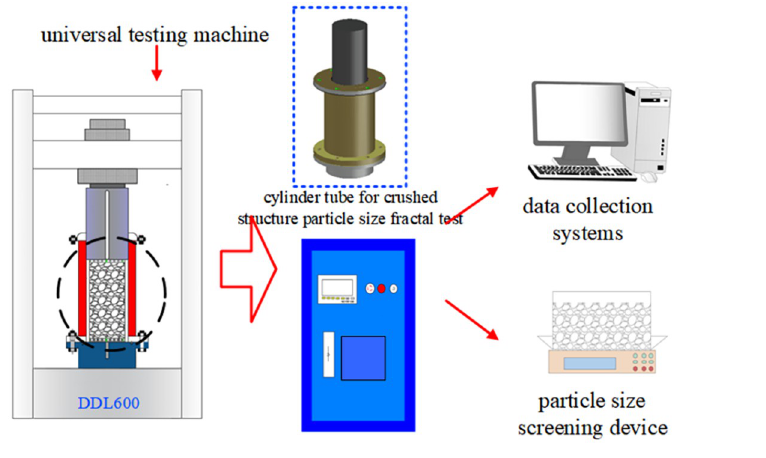
Fig 1. Test device.